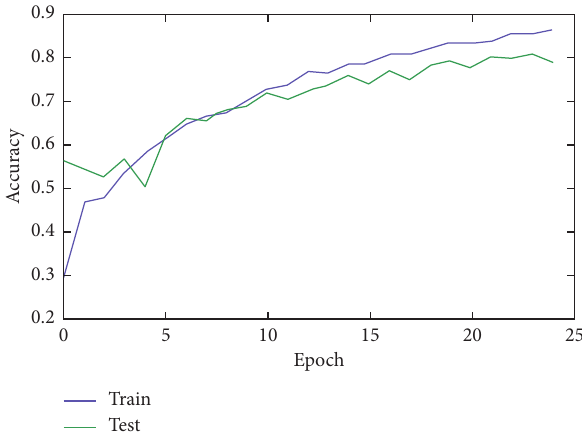
Figure 12: Proposed model accuracy.